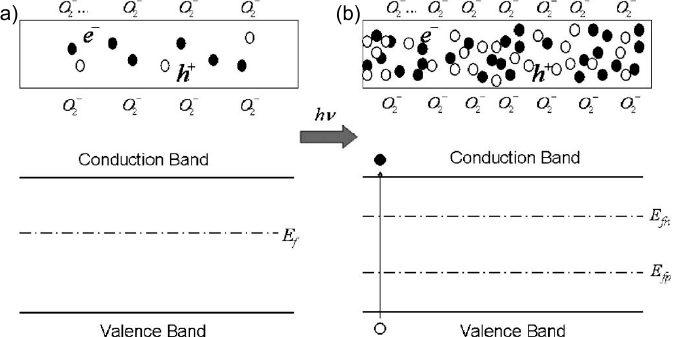
Figure 18. Schematics and energy ‐ level representations of the β‐ Ga 2 O 3 nanowires ( a ) before and ( b ) after the 254 nm UV illumination [107]. Copyright 2006 American Institute of Physics.